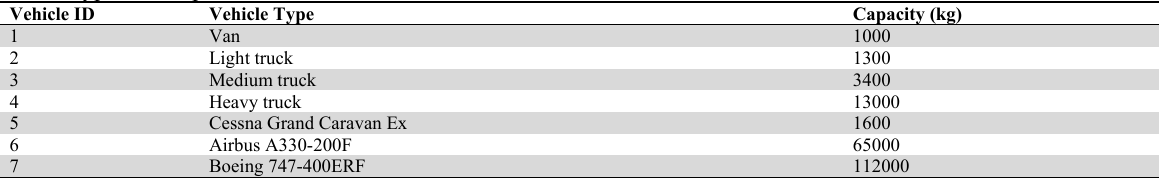
Vehicle types and